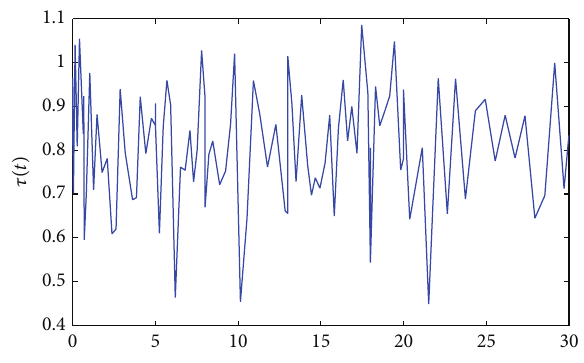
Figure 1: Operation modes.